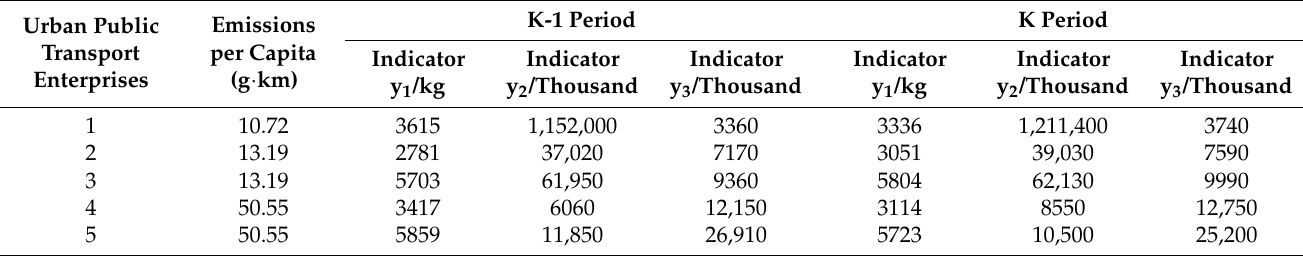
Table A1. Original data of urban public transport enterprises (refer to China Energy Statistics Yearbook and China Transportation Yearbook).